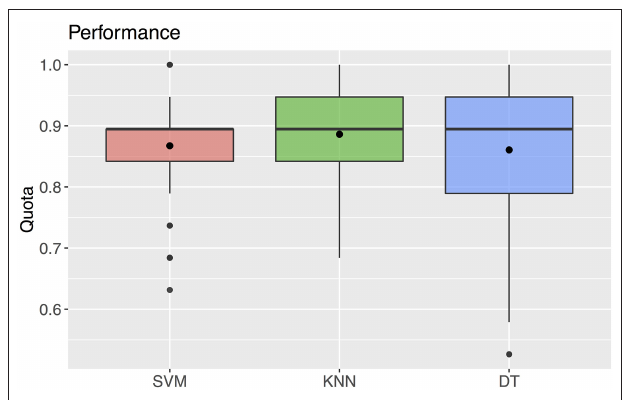
FIGURE 6 | Quota for the three machine learning methods SVM, KNN, DT. The black rectangles denote the mean values. The boxplots show a median of 0.895 for all three parameters.